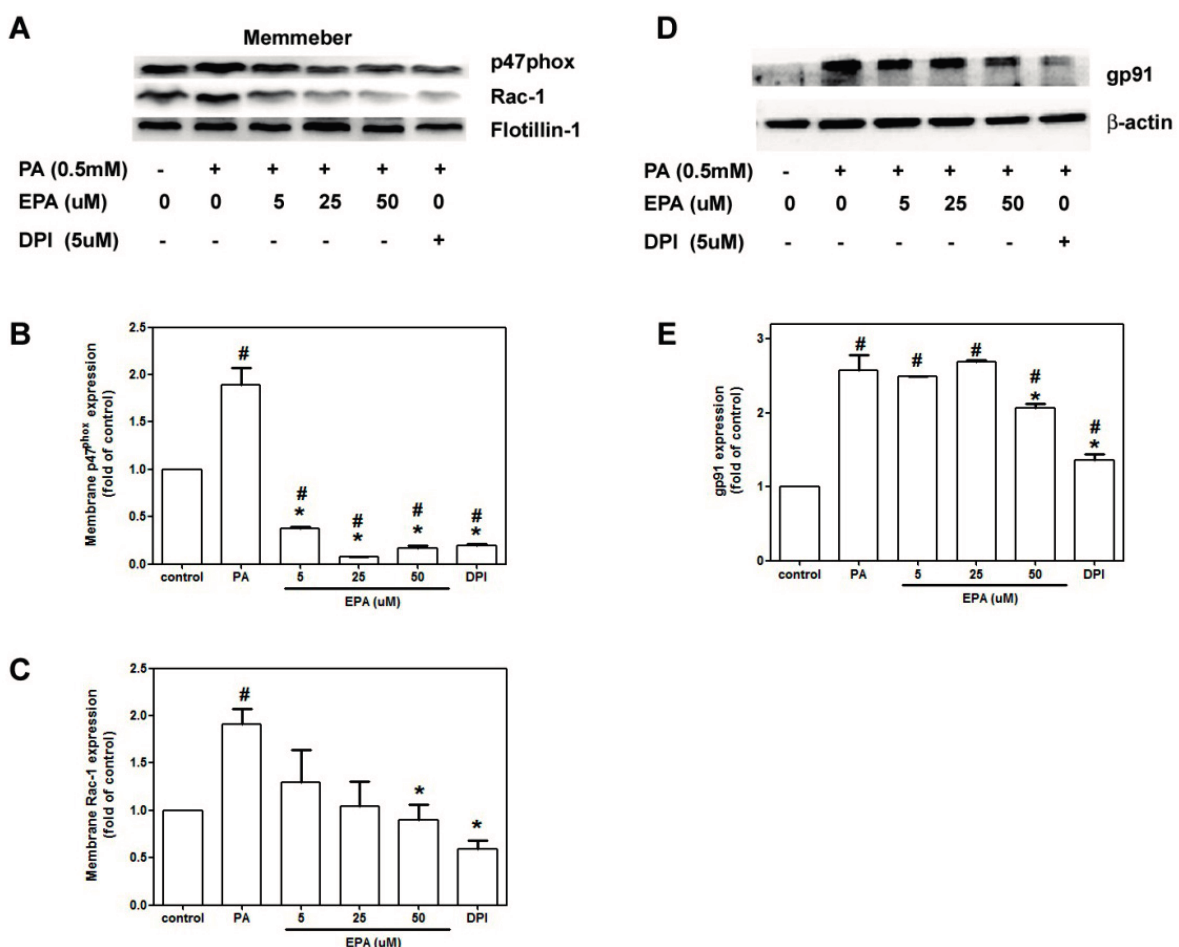
Figure 5. Effects of EPA on PA-induced NADPH oxidase activation. The HUVECs were pretreated with EPA 2 h prior to 18 h of incubation with PA (0.5 mM). The membrane and cytosolic proteins were extracted. Representative immunoblots for p47phox, Rac-1 and Flotillin-1 in the membrane ( A ) and gp91 in the cytosol ( D ) fractions; Densitometric analyses of the expressions of p47phox ( B ); Rac-1 ( C ) and gp91 ( E ) are shown. The values are presented as the means ± the S.E.s of three independent experiments. # p < 0.05 vs. untreated control; * p < 0.05 vs. PA